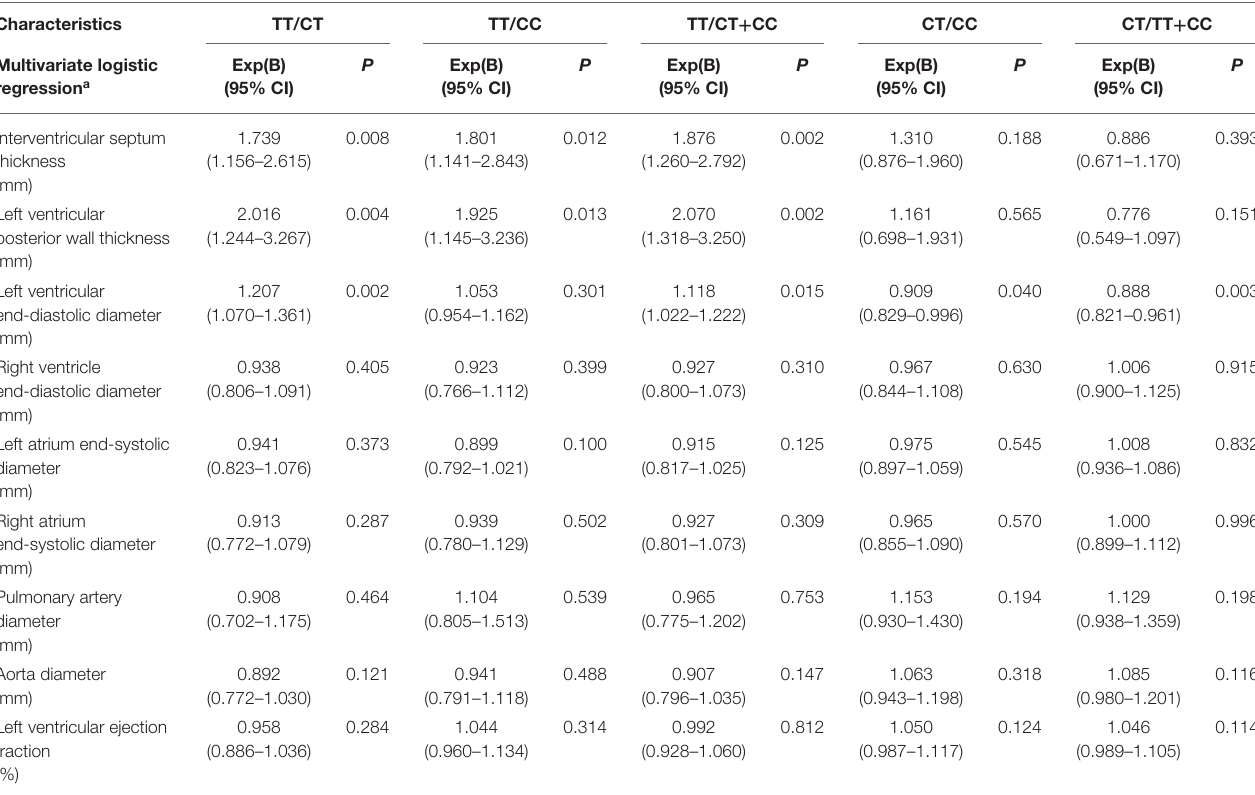
TABLE 6 | Associations of cardiac structure and function with different genotypes of rs189037 in the middle-aged and elderly.